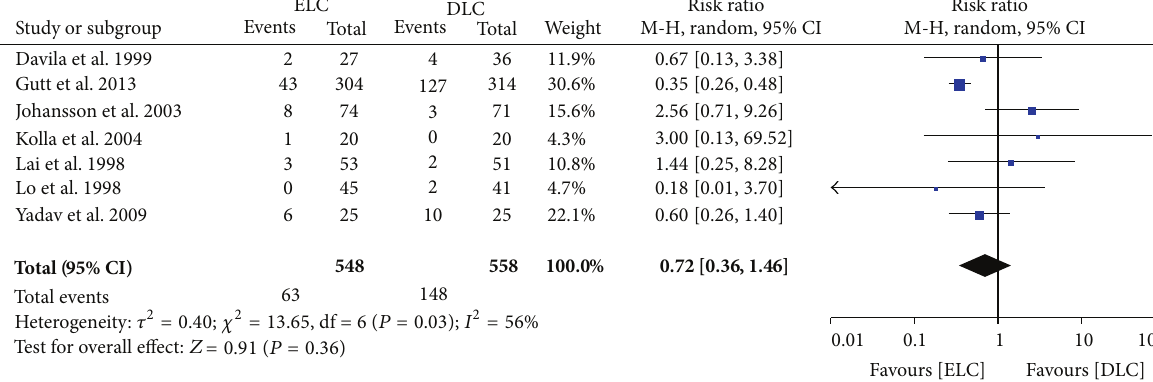
Figure 2: Meta-analysis of other complications in ELC versus DLC. Risk ratio shown with 95% confidence intervals.